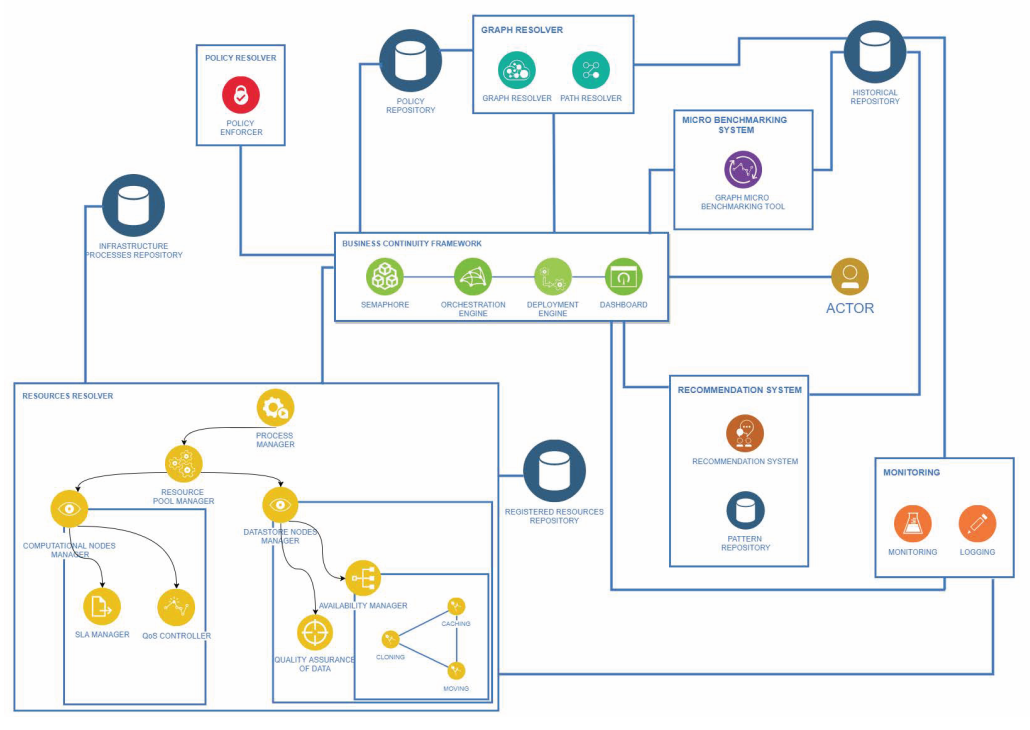
Figure 12. System